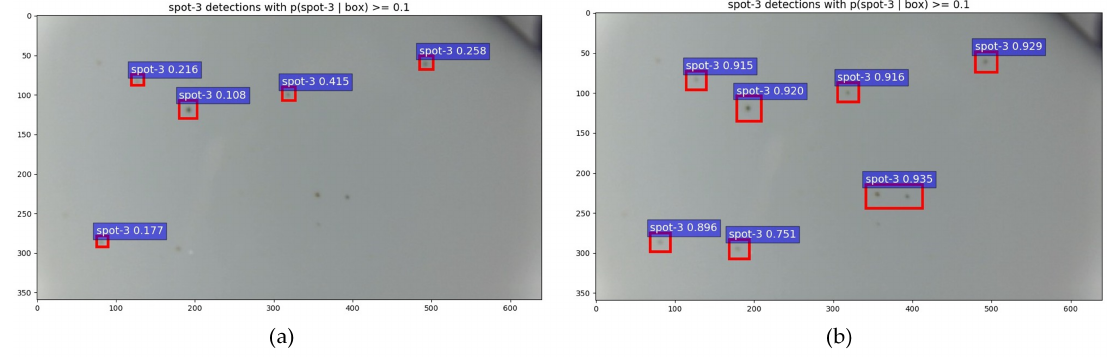
Figure 9. Comparison plot. ( a ) Defects detected by the standard network, ( b ) defects detected after adding